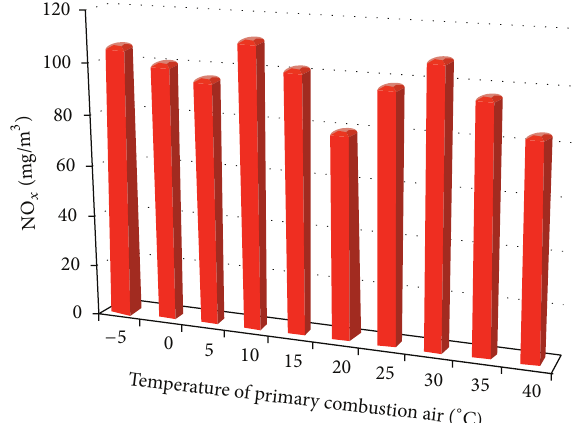
Figure 6: Average NO 𝑥 emissions depending on the temperature change of the primary combustion air.